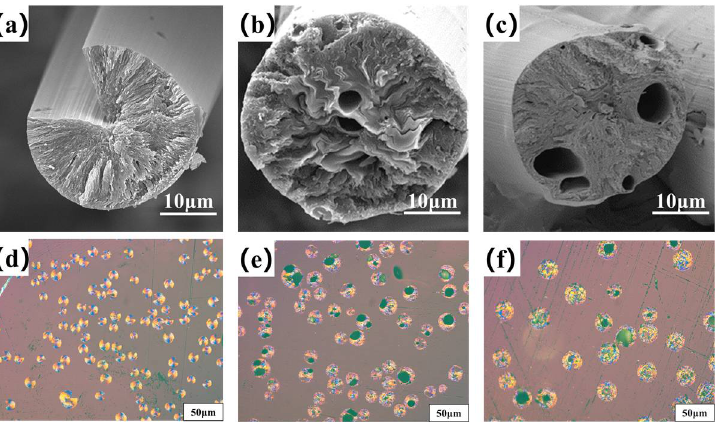
Figure 4. SEM images and POM photos of B0−MP−CF−1000 ( a , d ), B1−MP−CF−1000 ( b , e ) and B5−MP−CF−1000 ( c , f ).